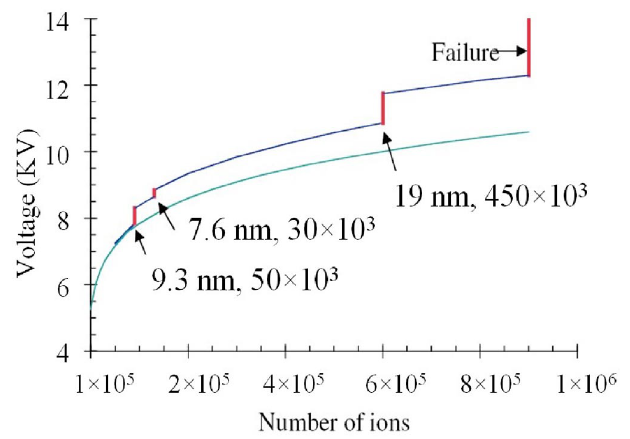
FIG. 3. (Color) Abrupt discontinuities in the voltage versus number of ions in a field evaporation system show evidence for large clusters produced at field ion microscope tips, from Ref. [27]. The approximate size of the fragments can be esti- mated from the size of the discontinuity and the density of the